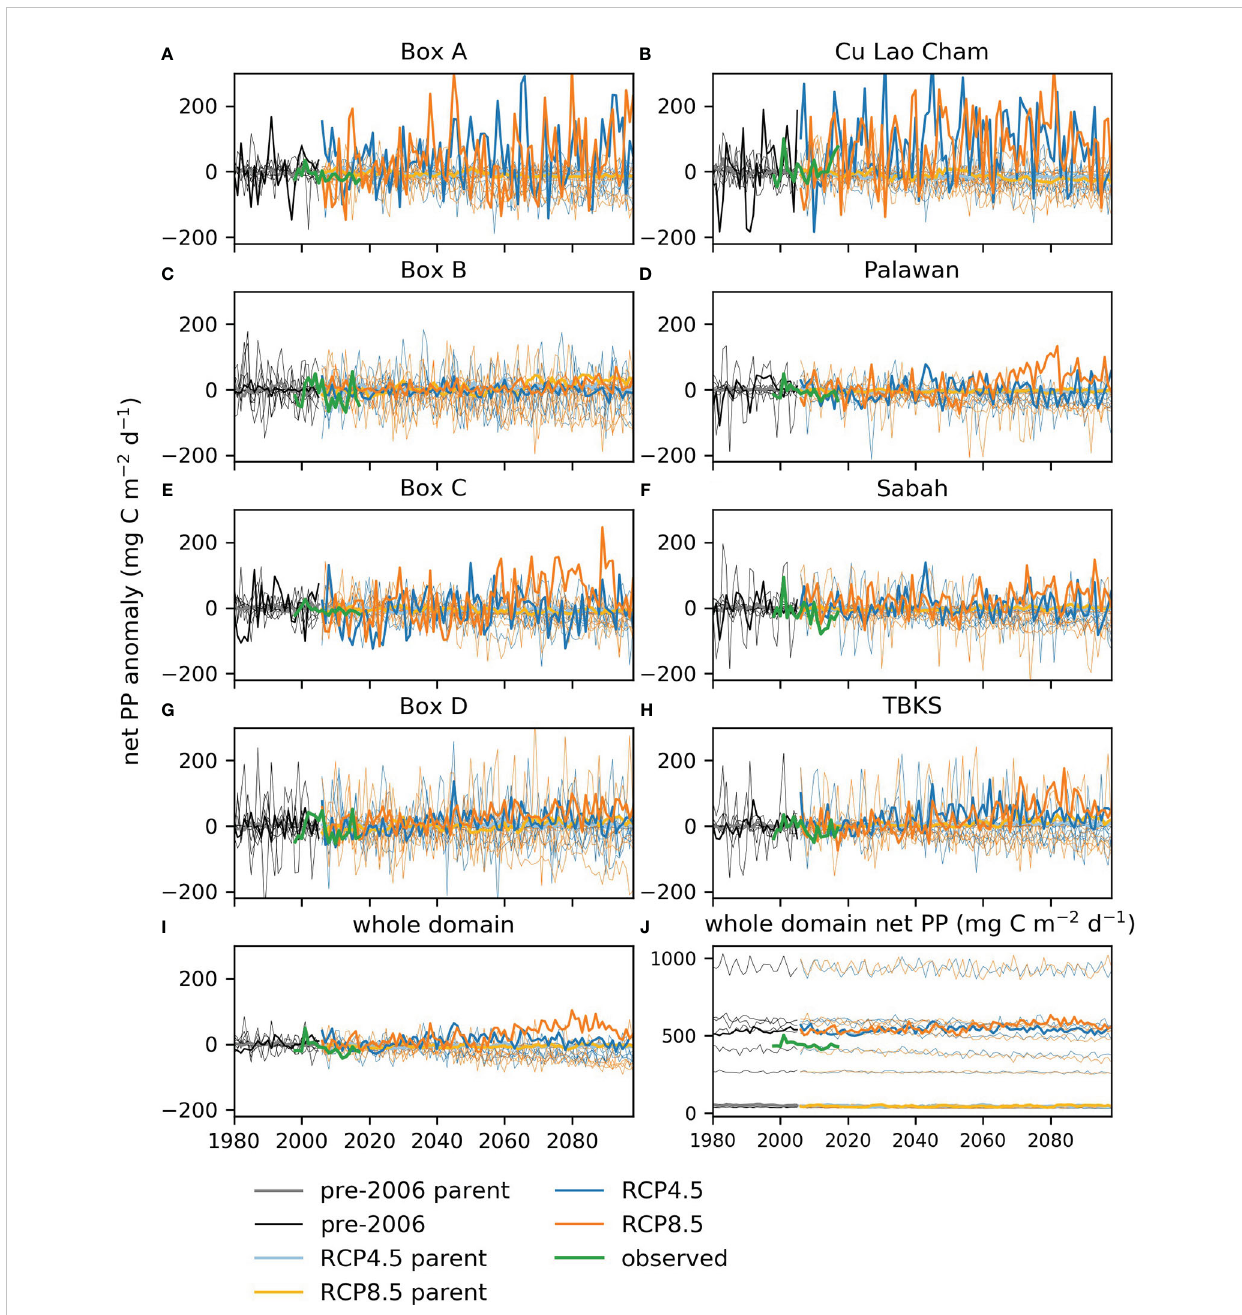
FIGURE 7 Column total net primary production for the sample areas de fi ned in Figure 1: (A – I) anomalies compared to the mean for 1980-2005 averaged over sample areas and the whole domain and (J) annual average for 1980-2098 for the whole domain. The darker lines show the regional model outputs, the paler color lines show the parent global model, the thinner lines show a range of other CMIP5 models. In each case the black lines show the CMIP5 historical period, 1980-2005, the blue lines RCP4.5 and the orange lines RCP8.5. The green line shows satellite-based values, see section 2.6 for product